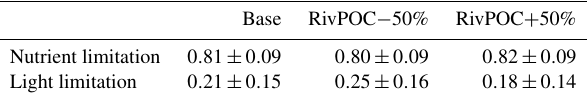
Table 2. Comparisons of nutrient limitation and light limitation on the growth of phytoplankton for Base and two POC simulations. Values are averaged over the bottom layer of the PRE. The lower values represent the stronger limitation.